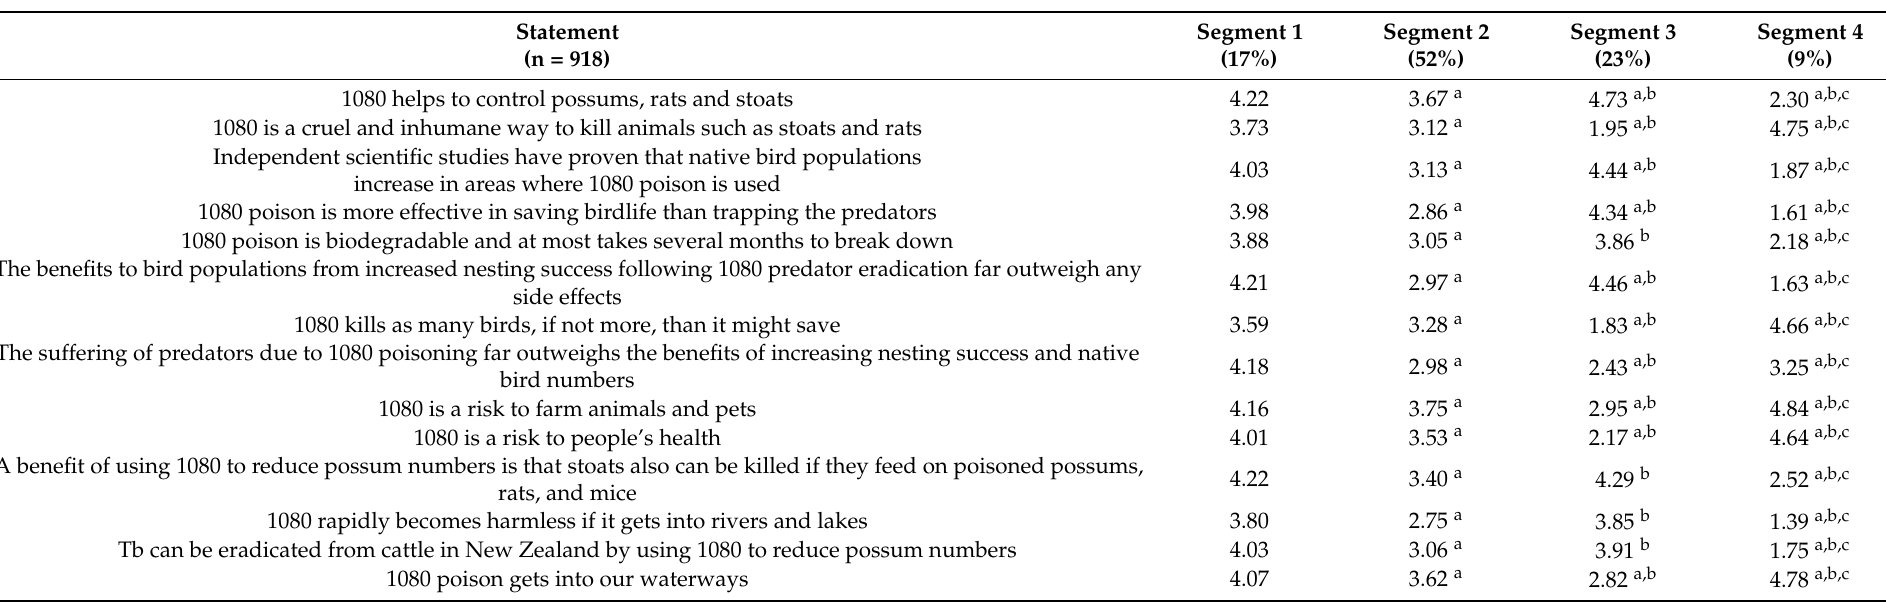
Table 3. Belief segments about